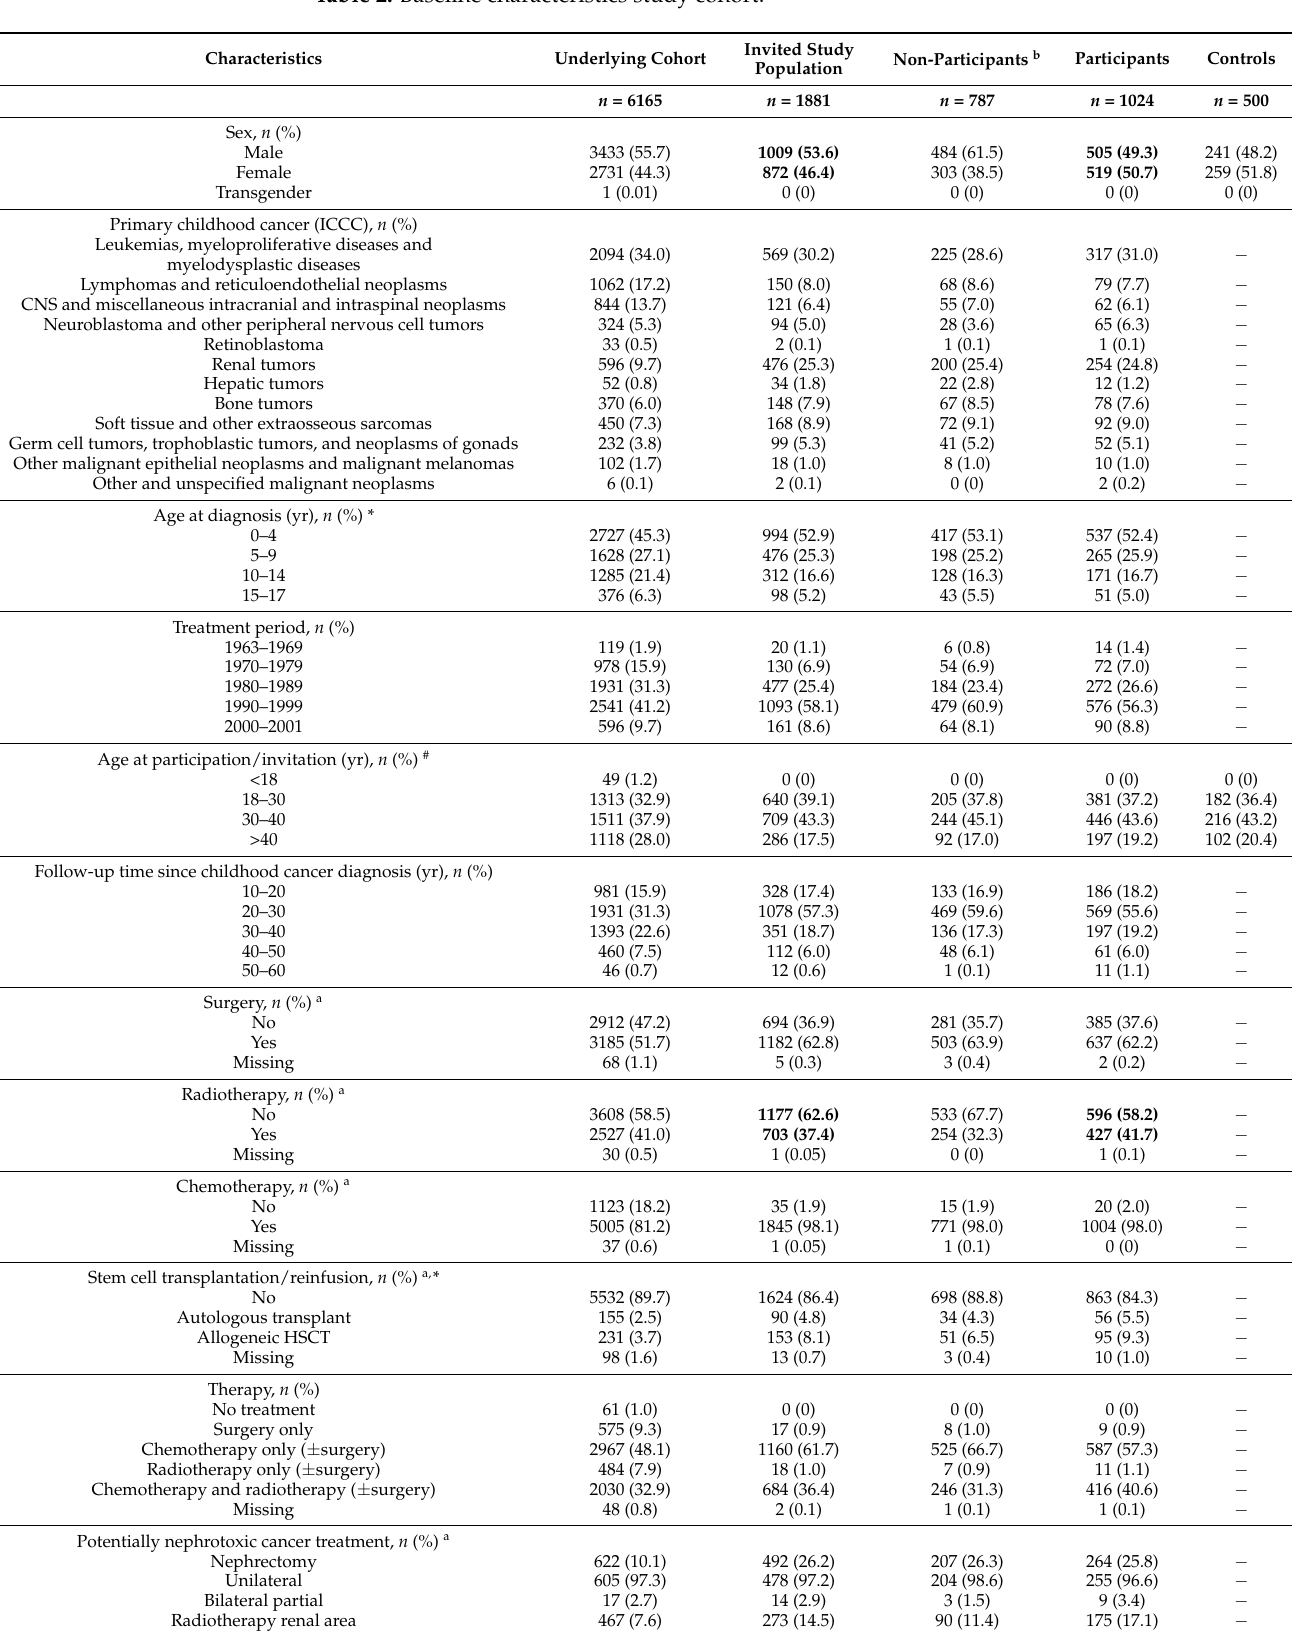
Table 2. Baseline characteristics study